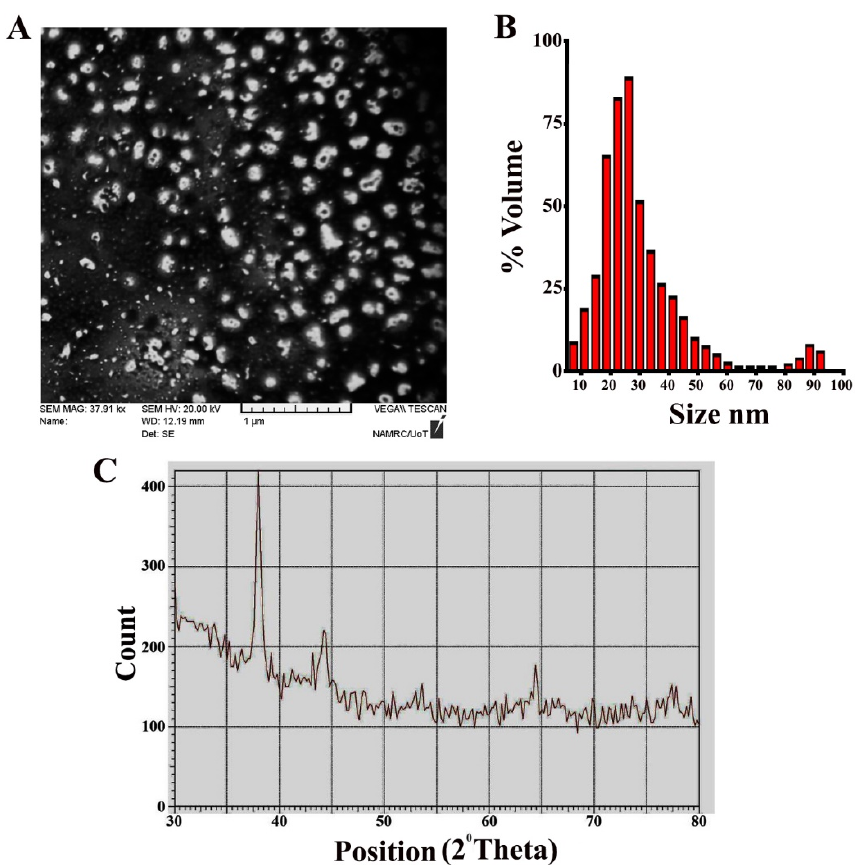
Figure 2. Morphological and structural characteristics of AgNPs. ( A ) SEM image. ( B ) DLS. ( C ) XRD pattern.